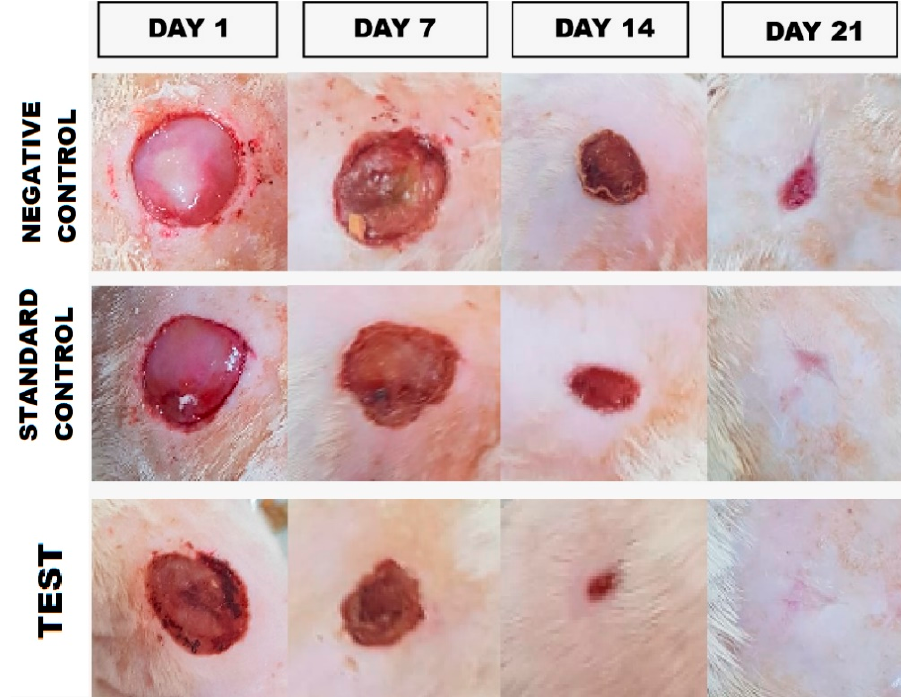
Figure 10. Photo images of the macroscopic observations of excision wound healed by different treatments at 1, 7, 14 and 21 days.